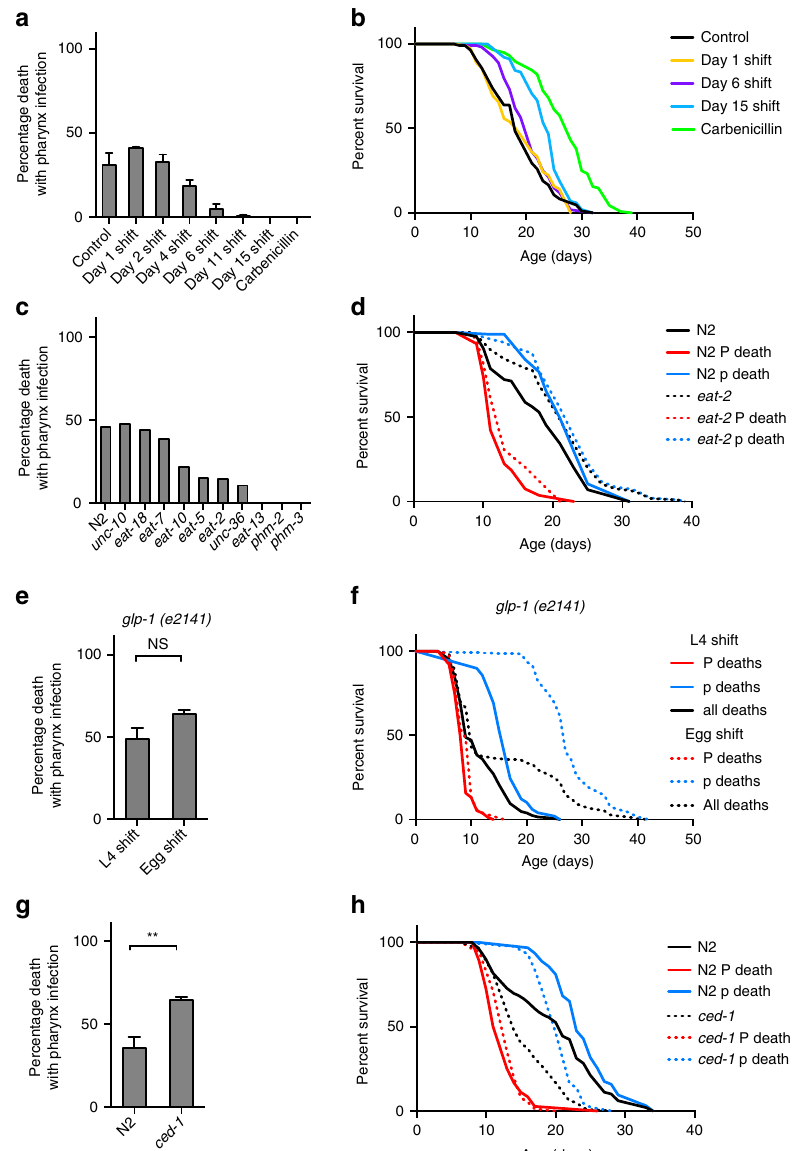
Figure 3 | High pharyngeal pumping rate promotes P death. ( a ) Effect of maintenance on non-proliferating E. coli (carbenicillin) during early life on frequency of P deaths. Exposure to proliferating bacteria in early-mid adulthood is required for P death to occur. (Trials: 2, for sample size, see Supplementary Table 4). ( b ) Maintenance on non-proliferating E. coli (carbenicillin) during early life reduces early mortality (data as in a ). ( c ) Effect of pumping-defective mutants on the frequency of P. (Trials: 1–2). ( d ) Effect of eat-2(ad1116) on lifespan. Whole population (black) or P and p deaths resolved (red and blue, respectively). Log-rank test between N2 and eat-2 whole populations P ¼ 0.0007, P death subpopulations P ¼ 0.1996, p death subpopulations P ¼ 0.0815. (Trials: 2, for sample sizes, see Supplementary Table 5). ( e ) Germline defective mutant glp-1(e2141ts) increases lifespan without affecting P death frequency when shifted to 25 (cid:2) C as eggs. (Trials: 2, for sample sizes see Supplementary Table 6). ( f ) Effect of glp-1 on lifespan, when shifted to 25 (cid:2) C at either egg (dotted) or L4 larval stage (solid). Median lifespan: L4 shift P deaths 9 days, p deaths 17 days; egg shift P deaths 9 days, p deaths 27 days (data as in e ). ( g ) ced-1(e1735) mutant increases the frequency of P deaths. (Trials: 2, for sample sizes, see Supplementary Table 7). ( h ) Effect of ced-1 (dotted) on lifespan compared to wild-type (solid). Median lifespan: ced-1 P deaths 13 days, p deaths 20 days; wild-type P deaths 13 days, p deaths 23 days (data as in g